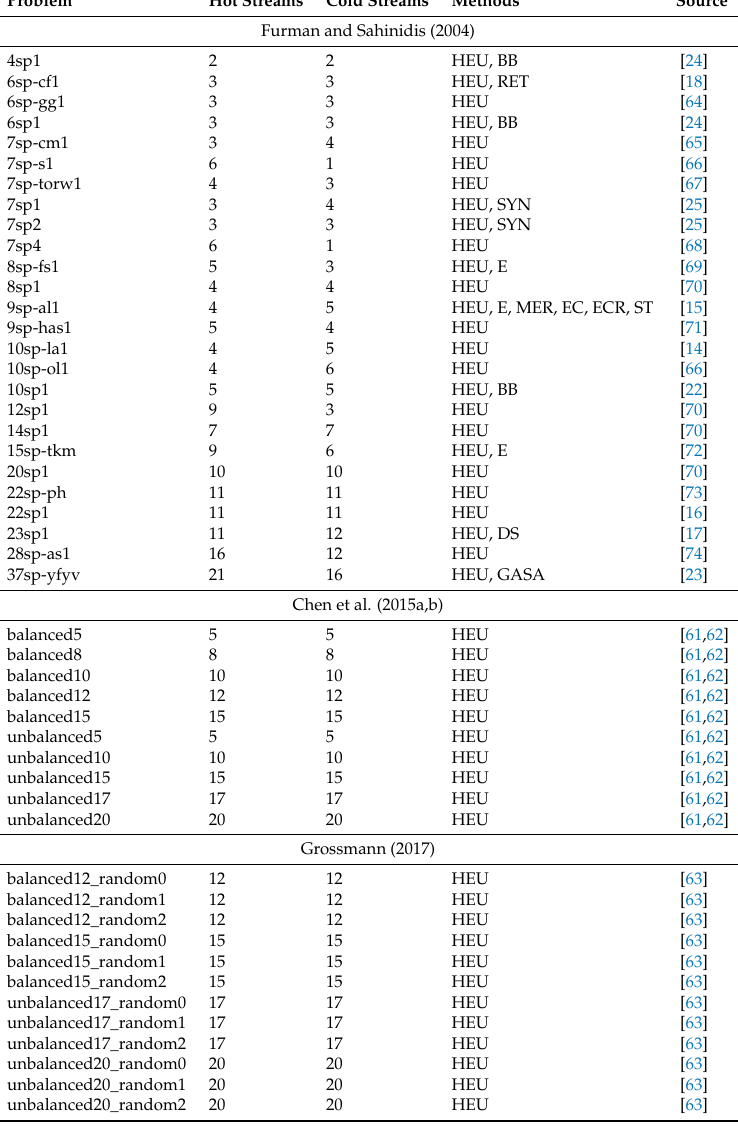
Table 3. Benchmark HENs and their optimisation methods that are used during the analysis. As the heuristic methods, CP, CRR, CSH, FLPR, GP, GSH, LFM, LHM, LHM-LP, LRR, SS, WFG and WFM were applied to each problem. This set of methods is denoted as HEU referring to heuristic methods. The methods are introduced in Table 4, where abbreviations are also